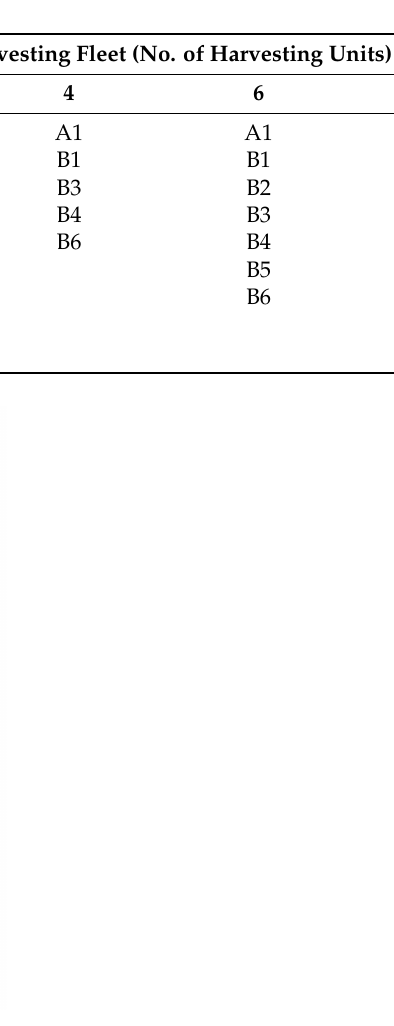
Figure 4. Base locations of machine/truck operators, harvesting units, and a relocation truck in the case harvesting area. The codes of locations are given in Table